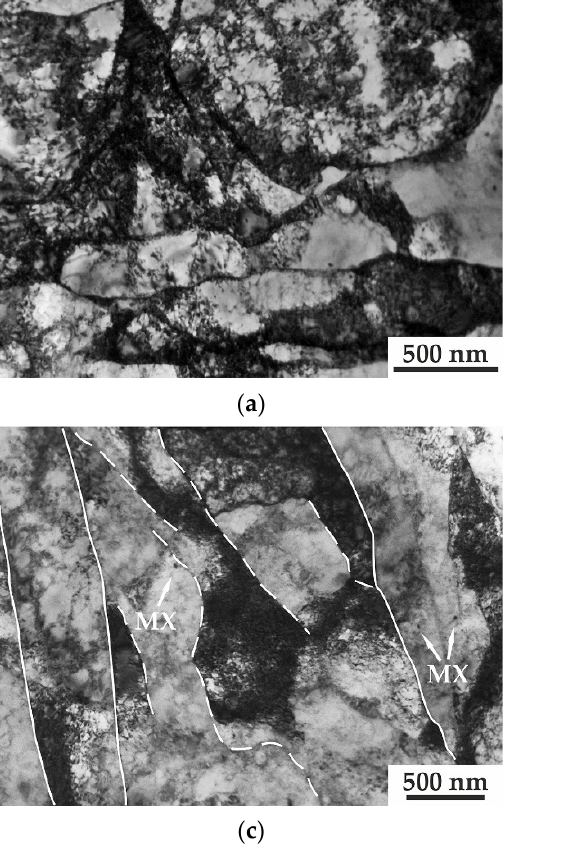
Figure 4. TEM images of steel microstructure after HTMT-2. BF images with fragmented structure ( a , c ), SAED patterns ( b , d ). Two zone axes—[110] γ and [001] γ are marked on ( b ). Solid lines on ( c ) indicate high-angle boundaries, dashed lines—low-angle.